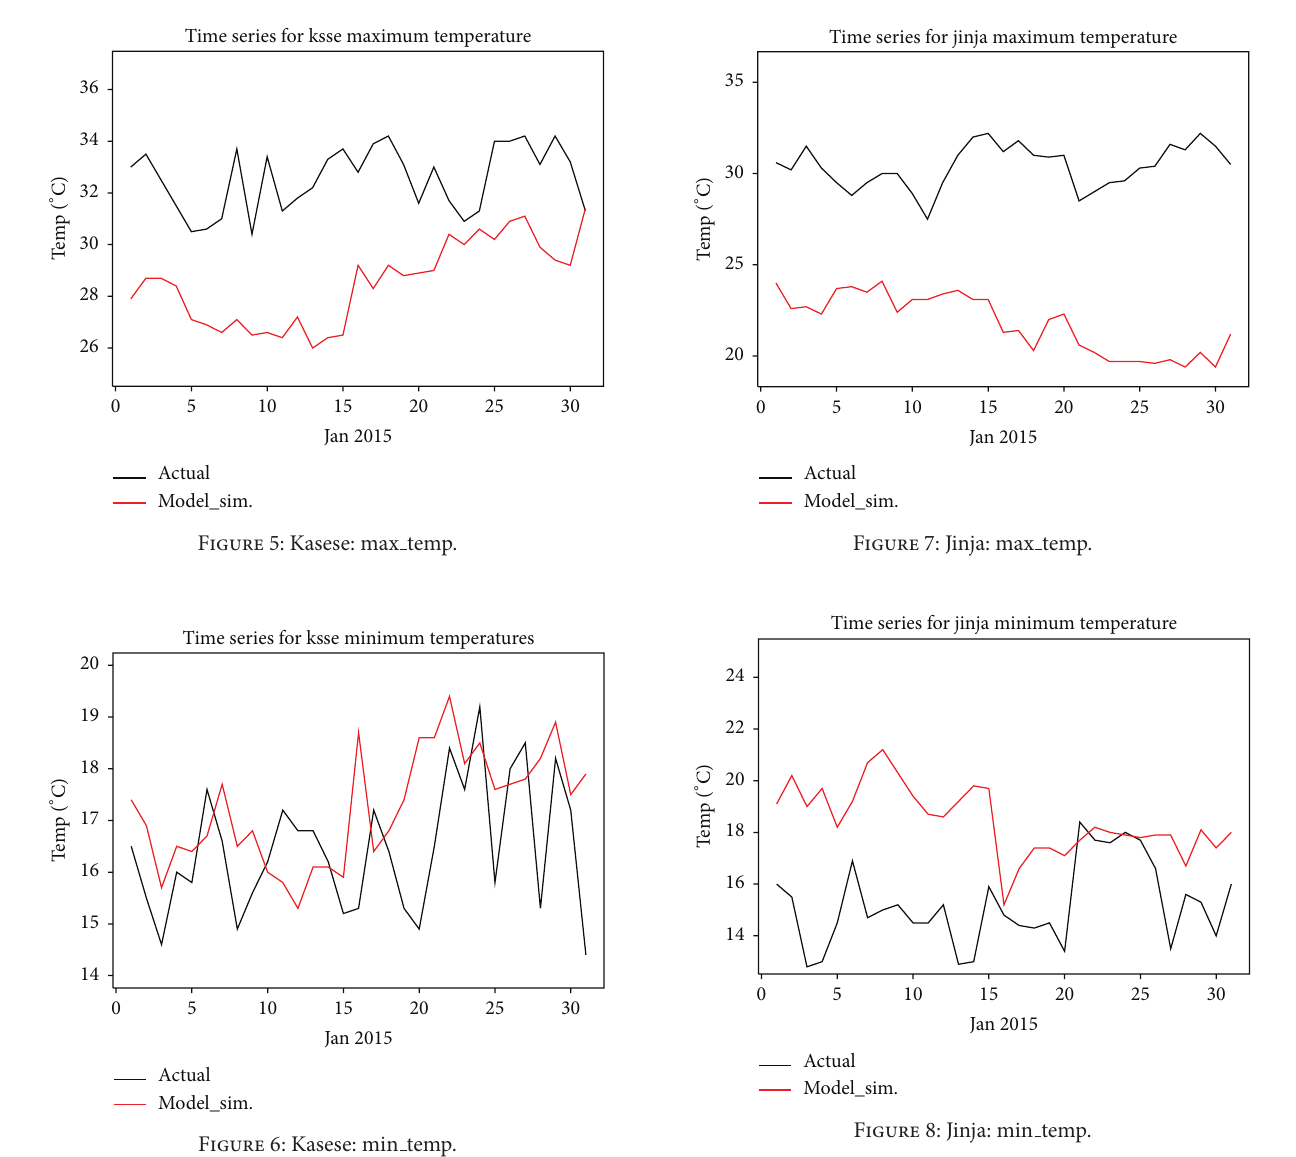
Figure 8: Jinja: min